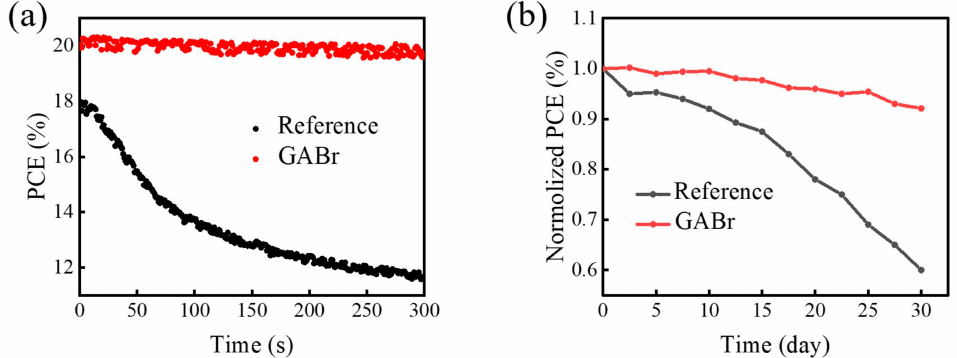
Figure 8. ( a ) Steady-state power conversion efficiency (PCE) of the champion devices with/without treatment, ( b ) Long-term stability trace of champion devices stored and tested in N 2 -filled glove box after 30